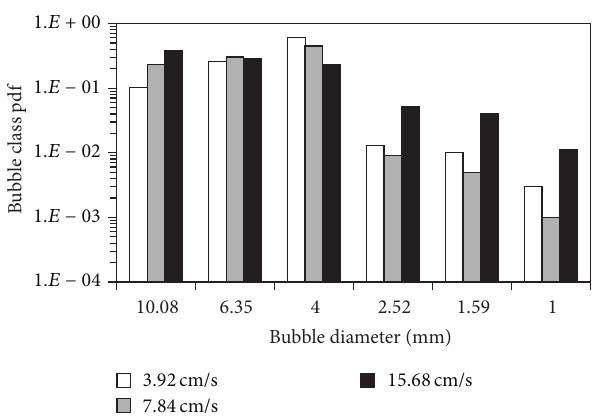
Figure 7: Variations in the volume averaged bubble probability density functions as a function of the inlet gas velocity for different bubble sizes (TFM + PB